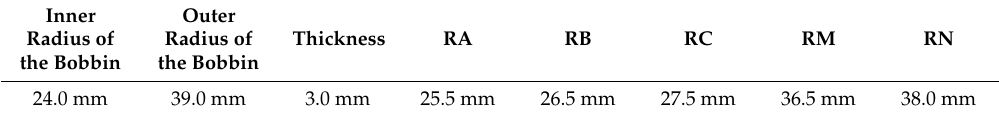
Table 3. Specifications of small turns.